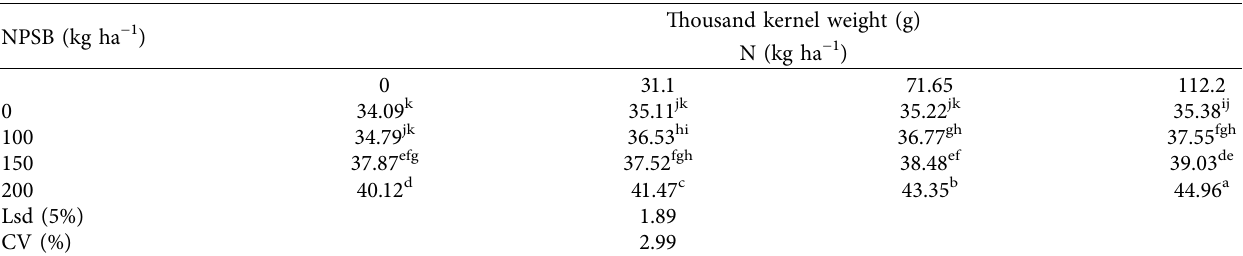
Table 6: Interaction effects of NPSB and Nitrogen fertilizer levels on thousand kernel weight (g) of bread wheat. NPSB (kg ha − 1 )